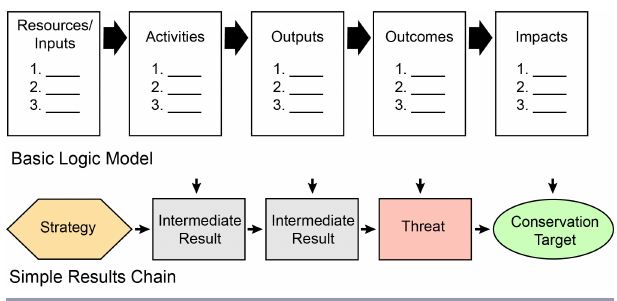
Fig. 2 . Comparison of the building blocks of a basic logic model and a simple results chain (modified from W. K. Kellogg Foundation 2001, Margoulis et al. 2013). The elements of a logic model are basically lists of items within each category with no indication how any one item connects with downstream items. In contrast, results chains show how strategies are expected to connect with impacts through intermediate results.